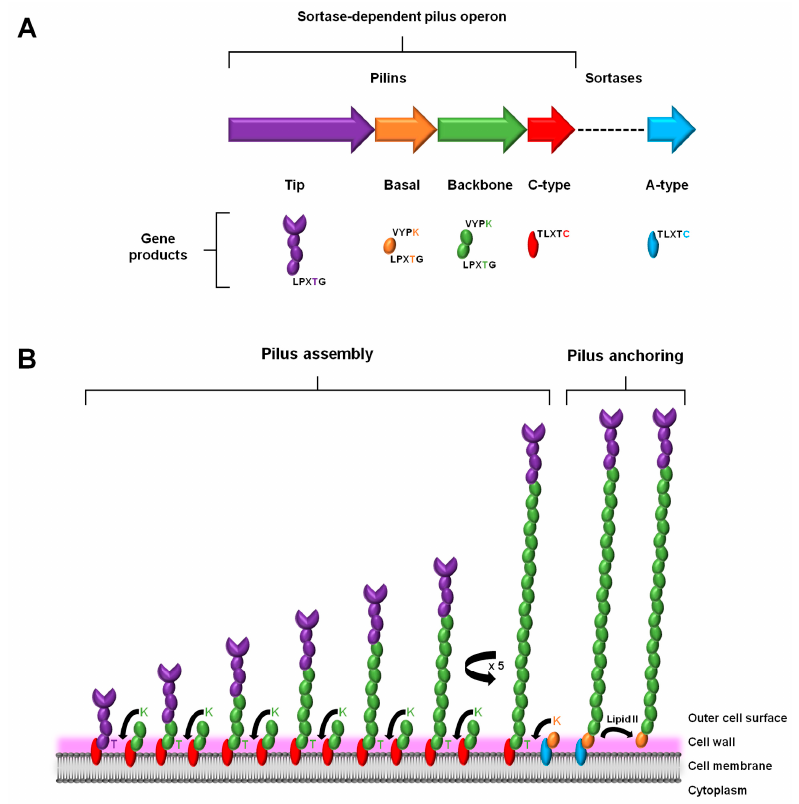
Figure 1. Genetics and mechanism behind the pilin assembly and cell wall anchoring of sortase-dependent pili. ( A ) Depicted is a schematic representation of a characteristic sortase-dependent pilus operon, which includes the genes for the tip, basal, and backbone pilin subunits and the pilus-specific C-type sortase enzyme. The housekeeping A-type sortase gene is invariably found elsewhere along the genome. Examples of the various pilin gene products are illustrated, and for each of these pilins, the location of the N-terminally located pilin motif (VYPK) and the LPXTG motif at the C-terminus are indicated correspondingly. Sortase gene products are shown with the conserved catalytic motif (TLXTC) in the vicinity of the active-site cleft. Key residues of each amino acid motif are highlighted by color. ( B ) Schematically depicted from left to right are the sequential steps leading up to the assembly and anchoring of a typical three-subunit sortase-dependent pilus. See ( A ) for the identities of the various pilins and sortases. (Refer to main text for details).